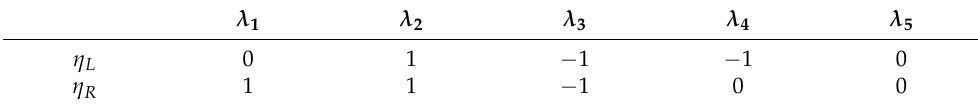
Table 3. Distribution of materials.